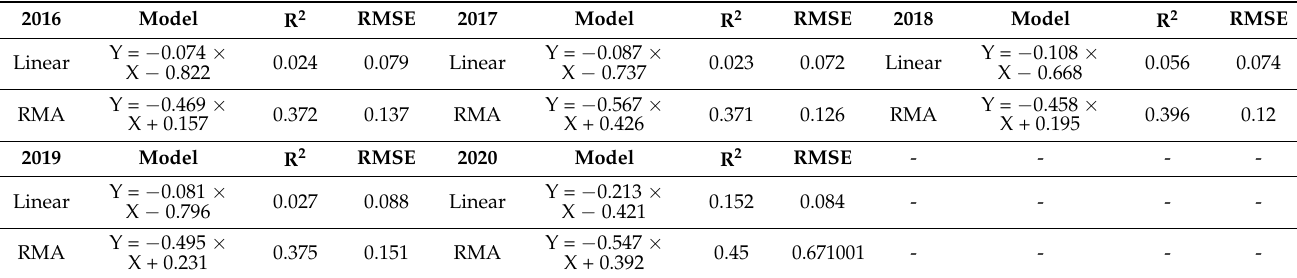
Table 3. The metrics of linear and LMA regression models between the PC and Sentinel-1 AER (R 2 : coefficient of